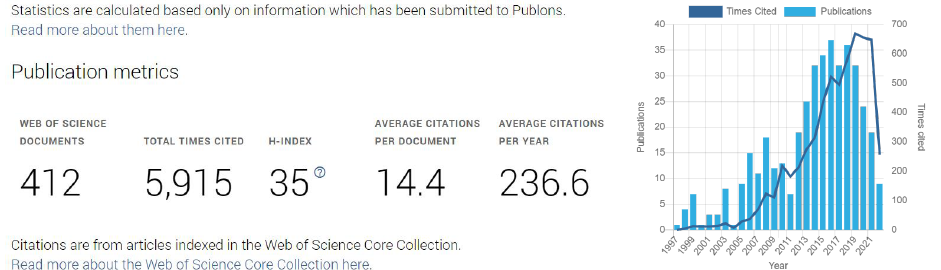
Figure 4. Statistics from Qi’s Publons profile dated on 2 August 2022.